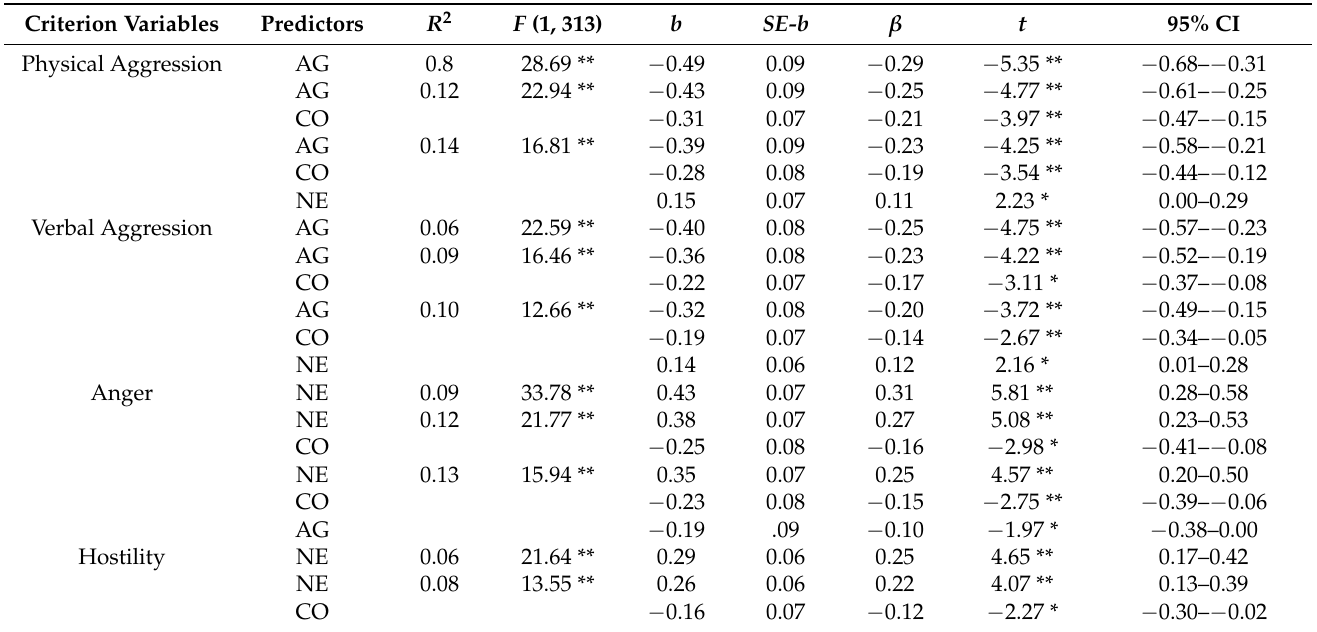
Table 3. Result of Stepwise Multiple Regression to predict Aggression from Big Five Personality